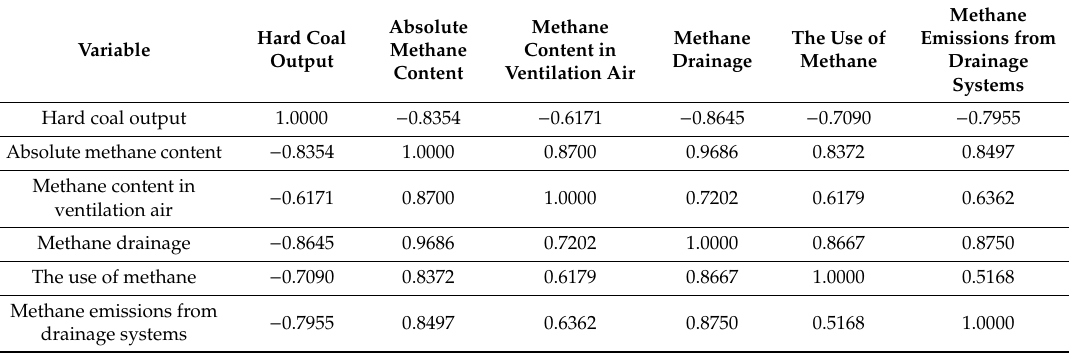
Table 3. The matrix of the correlation coe ffi cients between the variables under analysis for the methane extraction and emission from Polish hard coal mines between